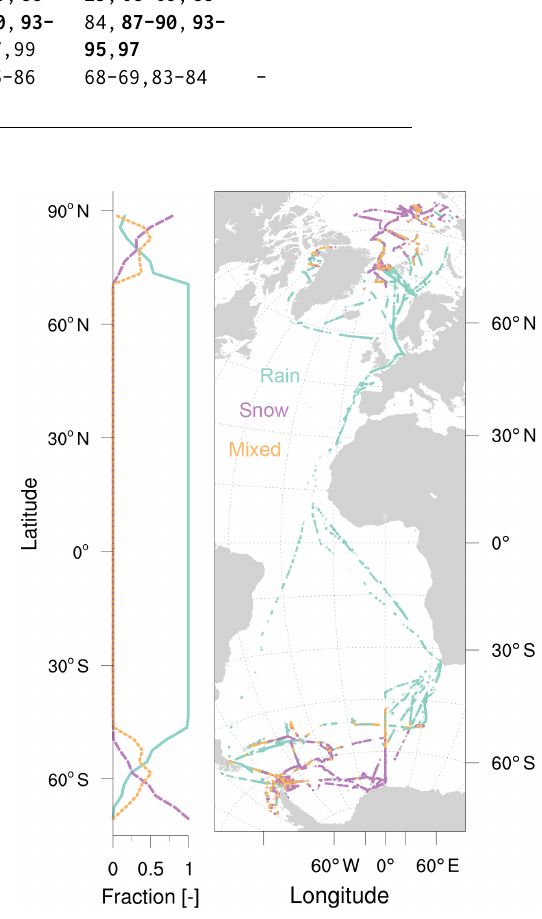
Figure 2. Map illustrates ship tracks from RV Polarstern ALL data (11 June 2010–8 October 2014), whereby dots denote minutes of occurring precipitation classified by the manual PP distinction (cyan: rain; orange: mixed phase; purple: snow). Harbor times and minutes without precipitation are not shown. Left side denotes the fraction of each PP averaged per